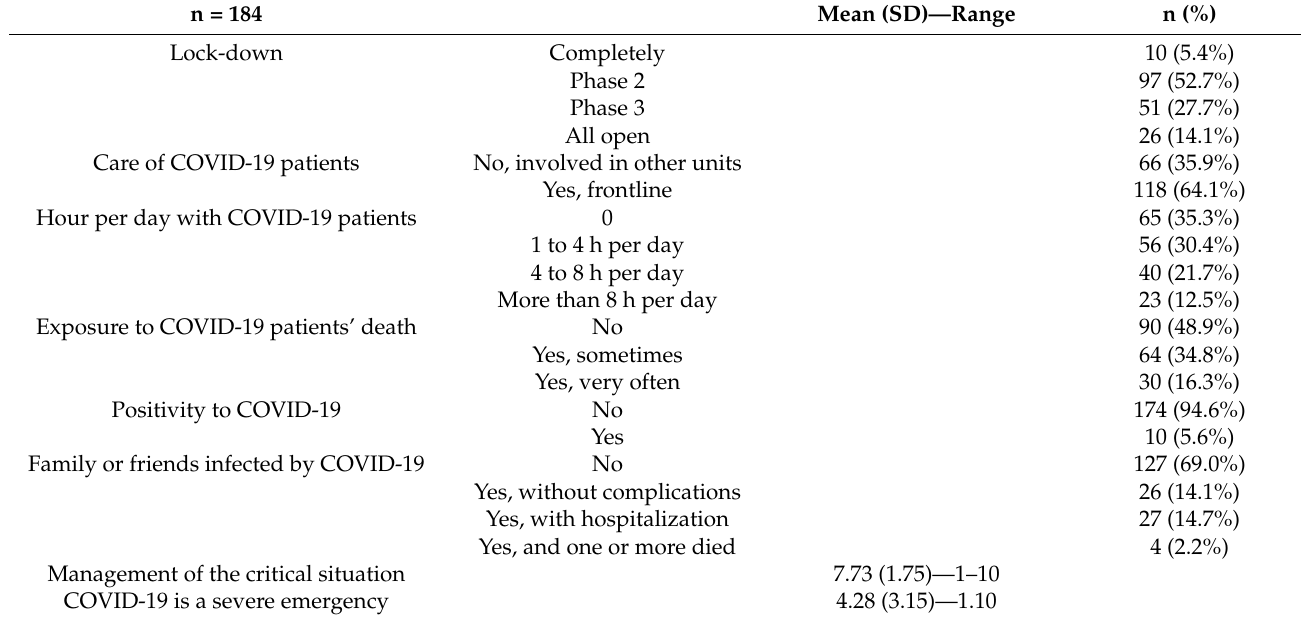
Table 2. COVID-19 outbreak individual